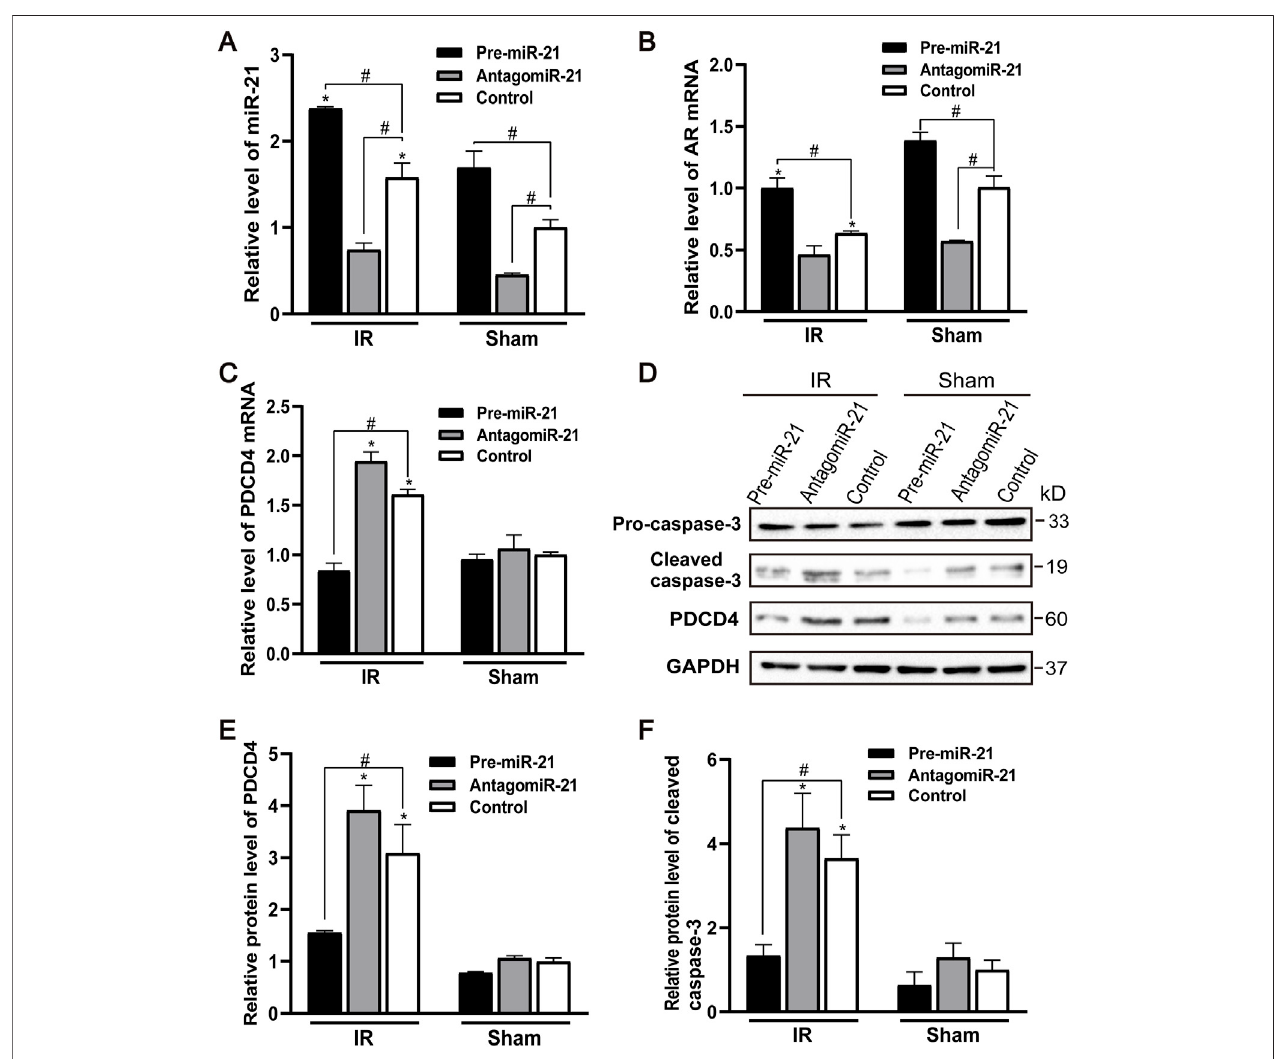
FIGURE 6 | MiR-21 reduces renal tubular cell apoptosis by targeting PDCD4 after ischemia-reperfusion injury. (A) qPCR showing pre-miR-21 treatment up- regulated miR-21 level, whereas antagomiR-21 down-regulated the expression of miR-21. (B) The expression of AR mRNA in the renal tissue by qPCR. (C) PDCD4 mRNA level was negatively correlated with the expression of miR-21 in mice with ischemia-reperfusion injury. (D) pre-miR-21 induced the expression of cleaved caspase-3 and PDCD4 protein after renal ischemia-reperfusion, yet antagomiR-21 reduced. (E) Quantitative evaluation of PDCD4 protein levels in renal tissue. (F) Quantitative evaluation of cleaved caspase-3 protein levels in renal tissue. Data displayed are mean ± SEM ( n > 5). Compared with sham operation group, * p < 0.05. Compared with Control + IR group, # p < 0.05.